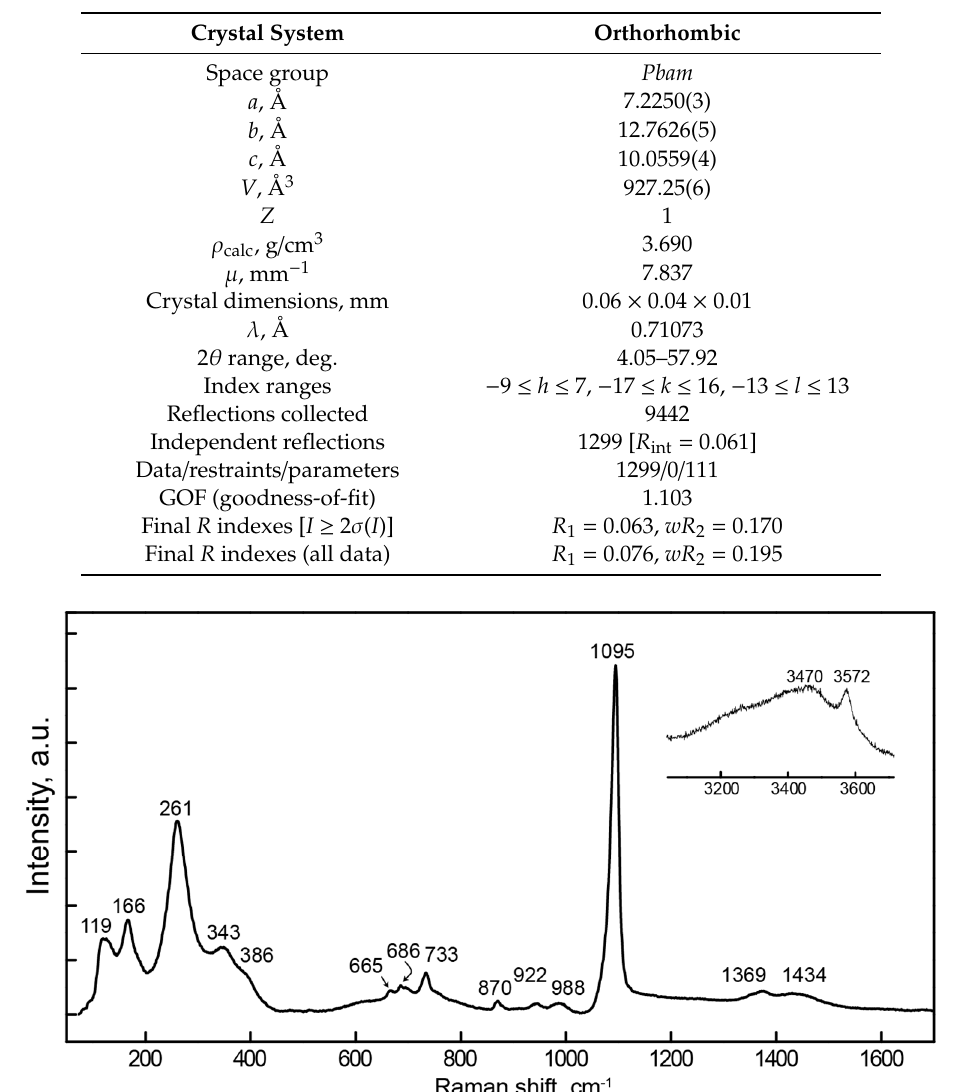
Table 1. Crystal data and structure refinement for paratooite-(La).